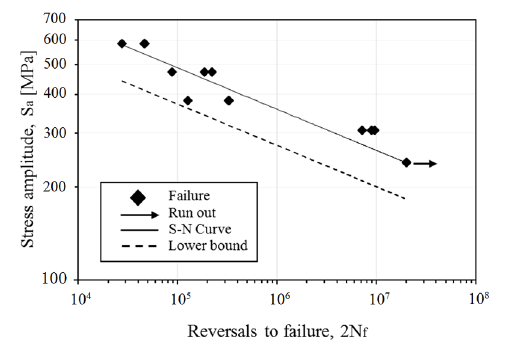
Figure 7. Fatigue test